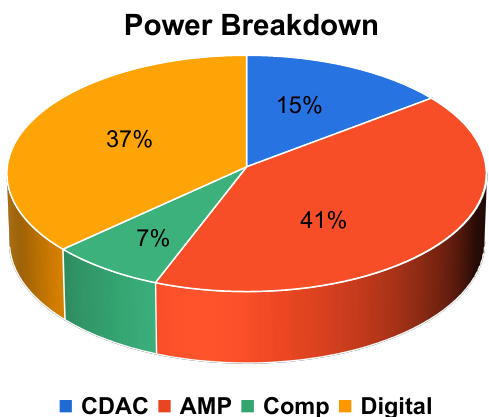
Figure 17. Power consumption